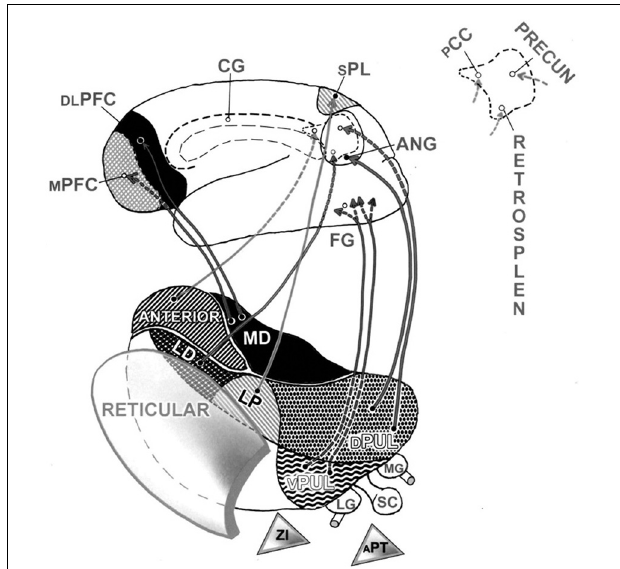
FIGURE 2 | Thalamocortical contributions to the dorsal egocentric and ventral allocentric processing streams. This composite view shows the pathways (normally bi-directional) which connect the thalamus with the cortex. For convenience in viewing, only left-sided structures are shown. These connections supply key regions both on the outside and inside of the left hemisphere. Pathways predominate from all five nuclei in the dorsal tier of thalamic nuclei. Up front are the three limbic nuclei. The medial dorsal (MD) thalamic nucleus projects to the prefrontal cortex, both to its medial (MPFC) and to its outer, dorsolateral (DLPFC) surfaces. The deep medial area of cortex in the back of the brain is shown enlarged at the top right. Here, the projections from the two other adjacent dorsal nuclei of the limbic thalamus can also be seen reaching this medial cortical surface (dashed lines). Thus, the anterior thalamic nucleus projects to the posterior cingulate cortex (PCC) (a major connection hub), and the lateral dorsal nucleus (LD) projects to the retrosplenial cortex (RETROSPLEN), a major memory-based resource for recollection. Down at the bottom right, one path leads up from the dorsal pulvinar (DPUL) to the angular gyrus (ANG) on the outer cortical surface. Dashed lines indicate that a second path from this dorsal pulvinar leads up to the precuneus (PRECUN) on the medial parietal surface. Other projections from the lateral posterior (LP) nucleus supply the superior parietal lobule (SPL), our major somatosensory association region. These connections help to anchor each person’s subliminal sensory impression: I exist as an independent, tangible, physically-articulated body schema. Relatively few pathways are shown emerging from the thalamus to serve the lower, allocentric processing stream. However, messages from the ventral pulvinar (VPUL) would pass first through the region of the fusiform gyrus (FG) on the undersurface of the temporal lobe. These associations ramify, to become further refined on their way forward and upward through the other-referential networks in the rest of the temporal lobe that lead on toward the frontal lobe. The figure shows three important GABA inhibitory nuclei, artificially detached at the bottom. They are the reticular nucleus , the zona incerta (ZI), and the anterior pretectal nucleus (APT). Two sensory relay nuclei of the thalamus are also shown at the bottom right. The lateral geniculate nucleus (LG) relays visual data to the occipital cortex. The medial geniculate nucleus (MG) relays auditory information to the auditory cortex. The superior colliculus (SC) in the midbrain relays its reflexive visual and related polymodal messages quickly through both the dorsal and ventral pulvinar to the cortex. Its counterpart, the inferior colliculus, plays a similar auditory role. Not shown are two somatic sensory relay nuclei in the ventral tier. These medial and lateral divisions of the ventral posterior nucleus lie in front of the ventral pulvinar. They relay sensation from the head and body, respectively. cingulate gyrus (CG).